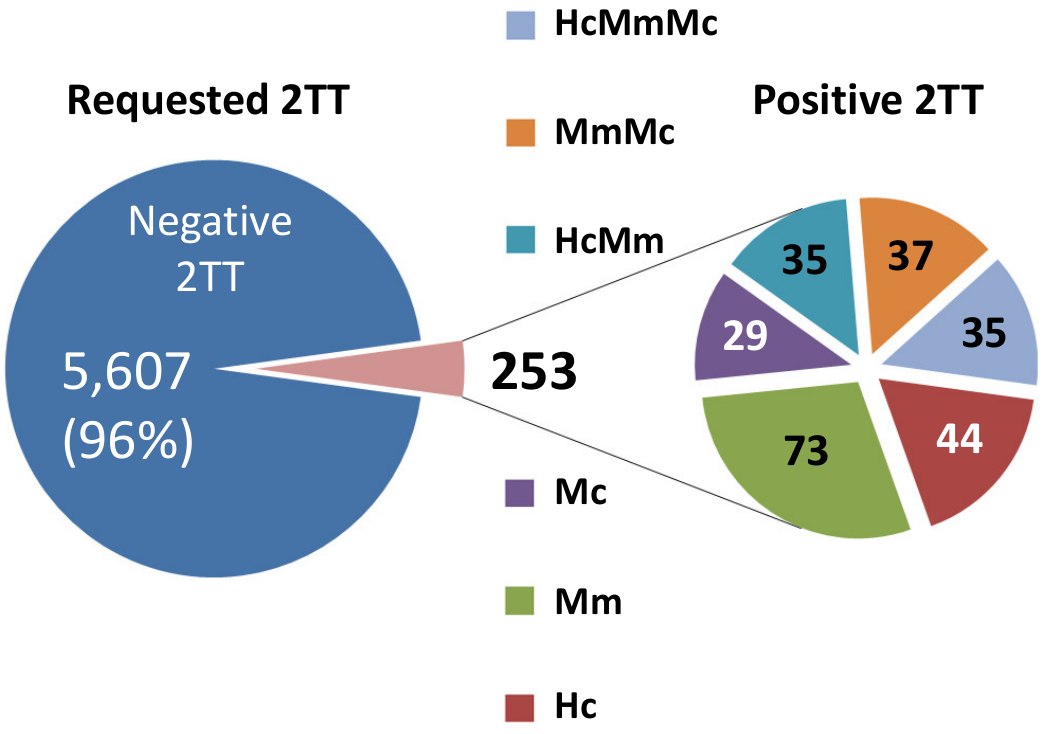
Figure 3. Distribution of cases with an abnormal 2TT. Hc, isolated elevation of tHcy; Mc, isolated elevation of MCA; other abbreviations are as in the legend of Figure